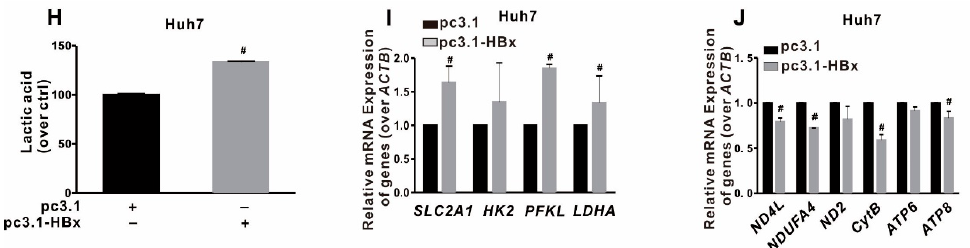
Figure 3. Glycolytic metabolism was reprogrammed in HBx-expressing Huh7 cells and liver cancer stem cells (LCSCs). ( A – E ) LCSCs were enriched in Huh7 cells by sphere-formation assay, and normally cultured Huh7 cells served as the parental cells (PT) control group. ( A ) Glucose transport activity was evaluated by Flows cytometry (FCM) (Left). The mean data was shown in bar graph (Right). The levels of intracellular ATP content ( B ), the extracellular lactic acid secretion ( C ), the mRNA levels of glycolysis-related genes ( D ), and the mRNA levels of OXPHOS-related genes ( E ) were detected in PT and LCSCs of Huh7 cells. ( F – J ) Huh7 cells without or with HBx-expressing were transiently transfected with pcDNA3.1 or pcDNA3.1-HBx (1 μ g/mL) for 8 h, and followed by restored culture for another 48 h. ( F ) Glucose transport activity was evaluated by FCM (Left). The mean data was shown in bar graph (Right). The levels of the intracellular ATP content ( G ), the extracellular lactic acid secretion ( H ), the mRNA levels of glycolysis-related genes ( I ), and the mRNA levels of OXPHOS-related genes ( J ) were detected in Huh7 cells without or with HBx-expressing. The target gene transcription was normalized to ACTB . * P < 0.05 as compared with PT cells group. # P < 0.05 as compared with pc3.1 group. pc3.1: pcDNA3.1 transfection without HBx-expressing. pc3.1-HBx: pcDNA3.1-HBx